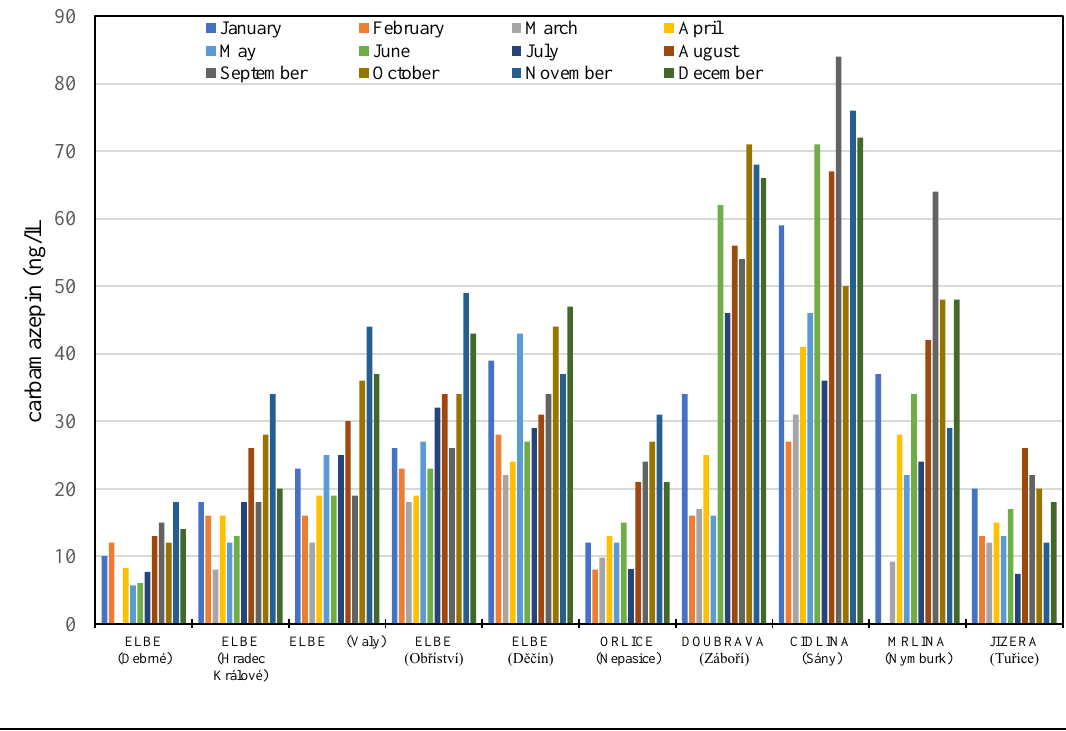
Figure 5. Residues of carbamazepine in surface water of the Elbe River basin.